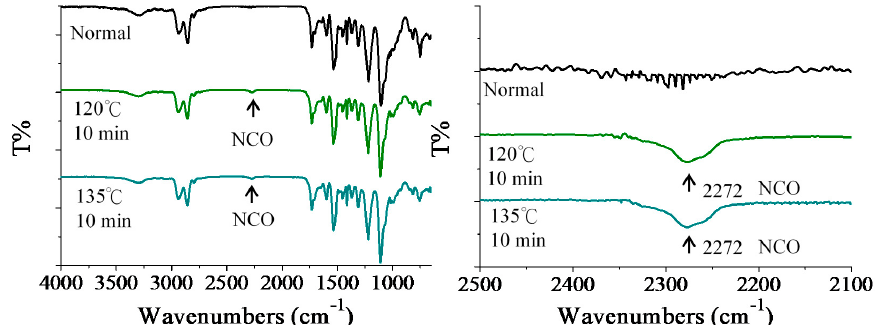
Figure 3. FTIR spectra of PTMG, castor oil and various cured PUR.